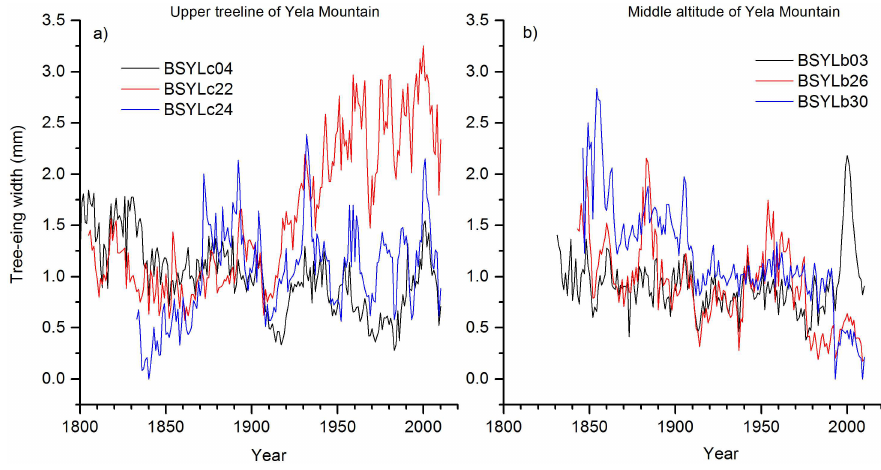
Fig 4. Fast radial growth in tree number 22 at the treeline (a), and examplesof different growth patterns among trees at the treeline and mid-elevation sites (b) in Yela